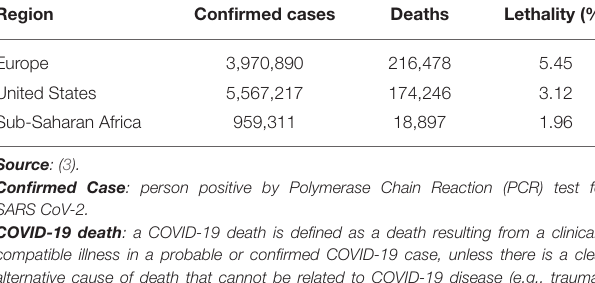
TABLE 1 | COVID-19 lethality rates in Europe, United States and Sub-Saharan Africa as of August 23, 2020. Region Confirmed